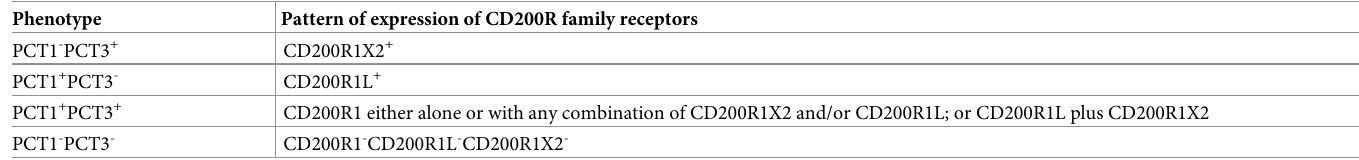
Table 2. Summary of the expression of porcine CD200R1, CD200R1L and CD200R1X2 receptors defined by different patterns of PCT1 and PCT3 mAb staining [19]. Phenotype Pattern of expression of CD200R family